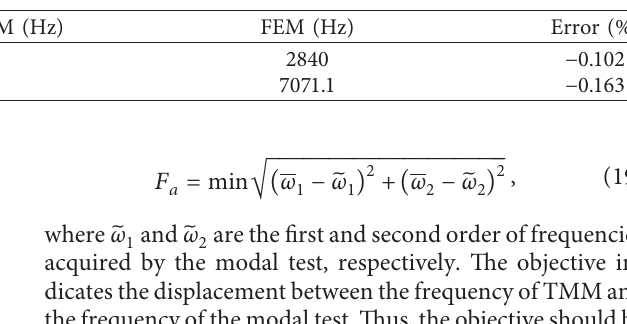
Figure 11: The main dimensions of the stepped shaft. Table 3: The results of the rotor modal by the modified TMM and FEM.